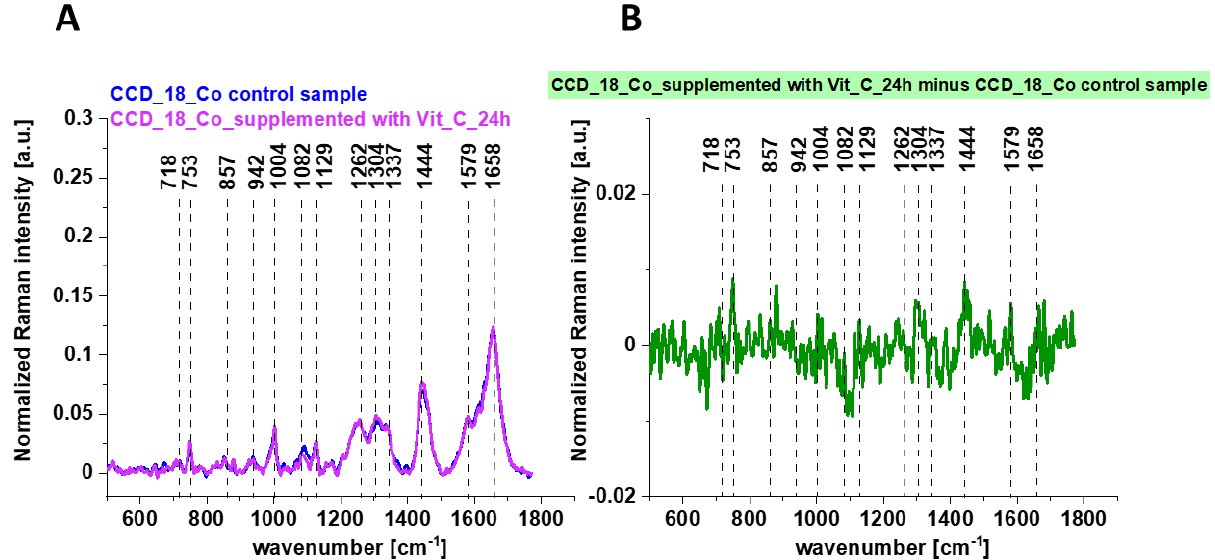
Figure 8. The average Raman spectra obtained for CCD-18 Co human normal control cells (control sample), the average Raman spectra typical for CCD-18 Co human normal control cells supplemented with vitamin C for 24 h ( A ) and the differential Raman spectrum ( B ) calculated based on spectra presented on panel (A); excitation laser line 532 nm; number of cells=6 for each type.